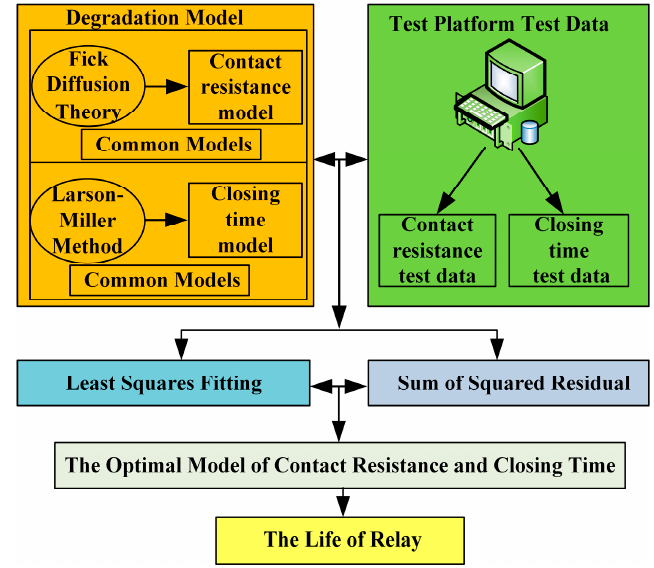
Figure 2. The reliability assessment method.